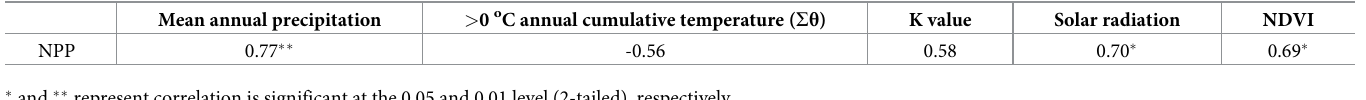
Table 2. Correlation coefficients between the annual average of grassland NPP and its related factors in Gansu during 1982~2011. Mean annual precipitation